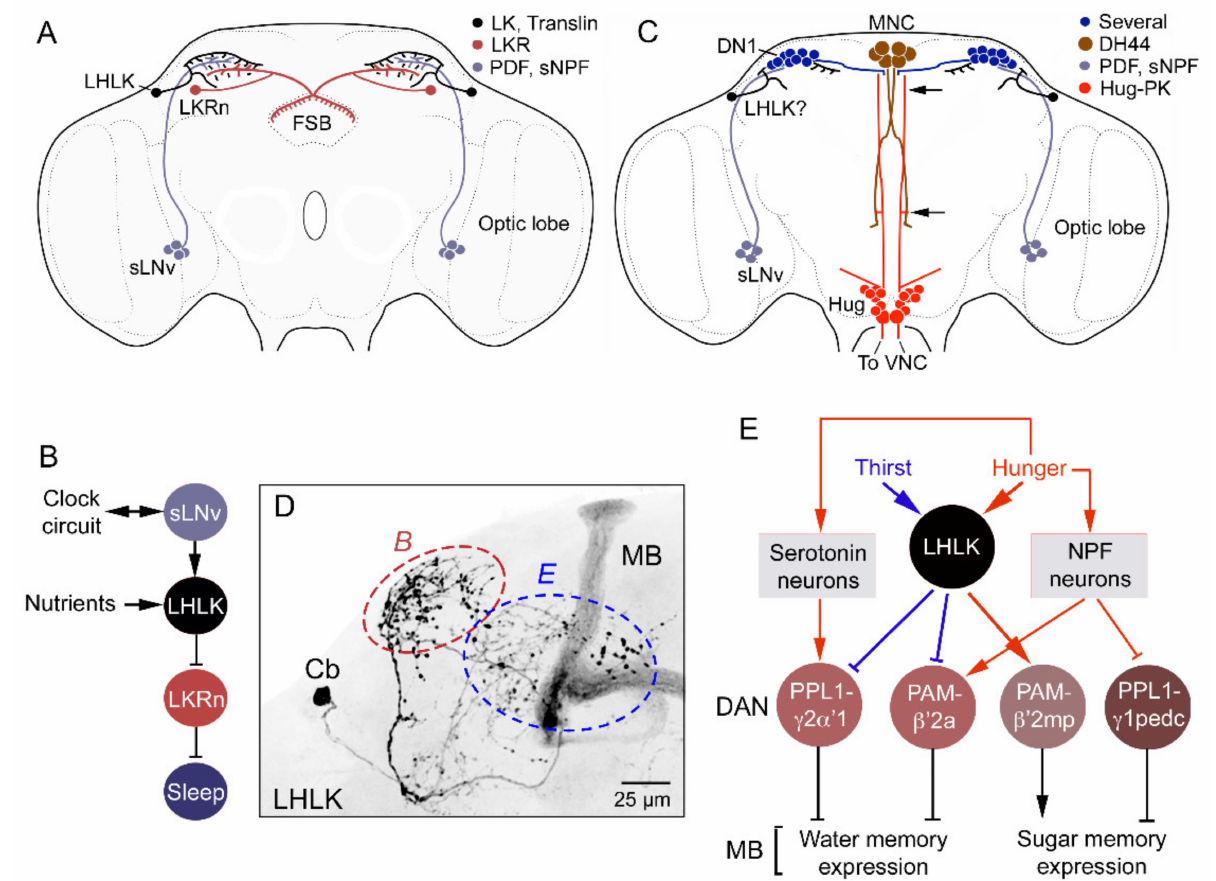
Figure 10. LK signaling in regulation of sleep–metabolism and water memory in Drosophila . ( A ) Schematic of brain neurons connecting clock, nutrient sensing and regulation of sleep. Clock neurons (sLNv, small lateral ventral neurons) have outputs on LHLKs that in turn inhibit LK receptor-expressing neurons (LKRn) innervating the fan-shaped body (FSB) and thereby inhibit sleep in a nutrient-dependent fashion. Figure compiled from data in [47,110,111]. Other abbreviations: PDF, pigment-dispersing factor; sNPF, short neuropeptide F. ( B ) A schematic of the connections in A. ( C ) Another sleep-regulating system in the brain with input from sLNv clock neurons (and possible inputs from LHLKs via dorsal clock neurons, DN1). sLNv neurons signal to DN1 clock neurons which, in turn, have outputs on median neurosecretory cells (MNCs) expressing DH44. The MNCs signal via one of the DH44 receptors (DH44R1) to Hugin neurons, which modulate motor circuits in the VNC. Data in this figure are compiled from [139,140]. The possible LHLK input was added here. ( D ) LHLK neuron with arborizations that interact with the circuits shown in panels B and E (red and blue dashed ellipses). ( E ) LHLK neurons and the circuit regulating water–sugar-based memory. The LHLK neurons receive hunger and thirst signals and act on dopaminergic neurons (DAN; PPL1 and PAM subtypes) to regulate expression of water and sugar memory in mushroom body (MB) circuits. Some of these neurons also receive inputs from serotonin and NPF (neuropeptide F) neurons. Redrawn from